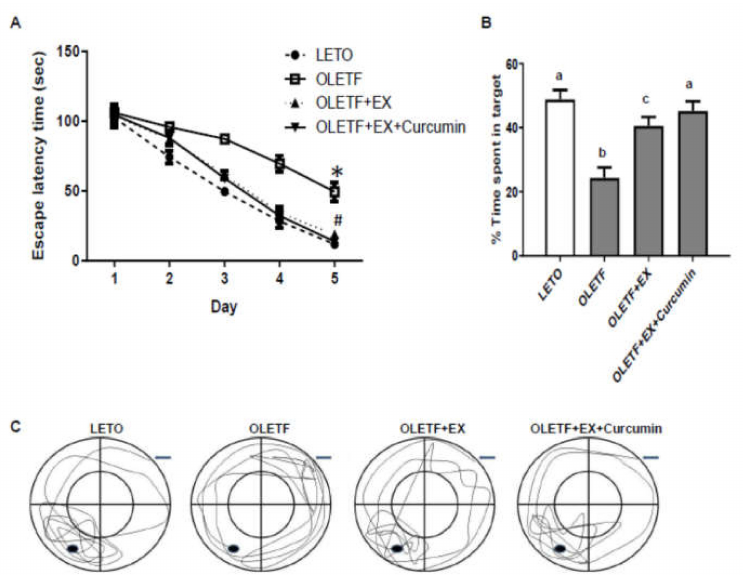
Figure 4. Curcumin plus exercise improved learning and memory retention of OLETF rats in the Morris water maze test. ( A ) Escape latency was measured with the platform in place. In four trials per day, experimental rats performed to obtain data for five consecutive days. * p < 0.05 vs. LETO rats of controls, # p < 0.05 vs. OLETF rats of controls. ( B – C ) The e ff ect of exercise plus curcumin on memory retention in the probe trial. Time spent in the target quadrant in the probe trial was calculated on the sixth day ( B ). The representative diagram of tracking on swim path length. The data were determined with a video tracking system ( C ) LETO controls: age-matched control group, OLETF controls: diabetic group, OLETF + EX group: diabetic exercise-trained group, OLETF + EX + Curcumin group: diabetic exercise-trained and curcumin fed (5 g / kg diet) group. Results are presented as means ± standard errors. Statistical analysis was conducted using one-way ANOVA for the probe trial and by using a two-way repeated measures ANOVA followed by Turkey’s post-hoc test for behavioral data. Di ff erent superscripts indicate significant di ff erence ( p <